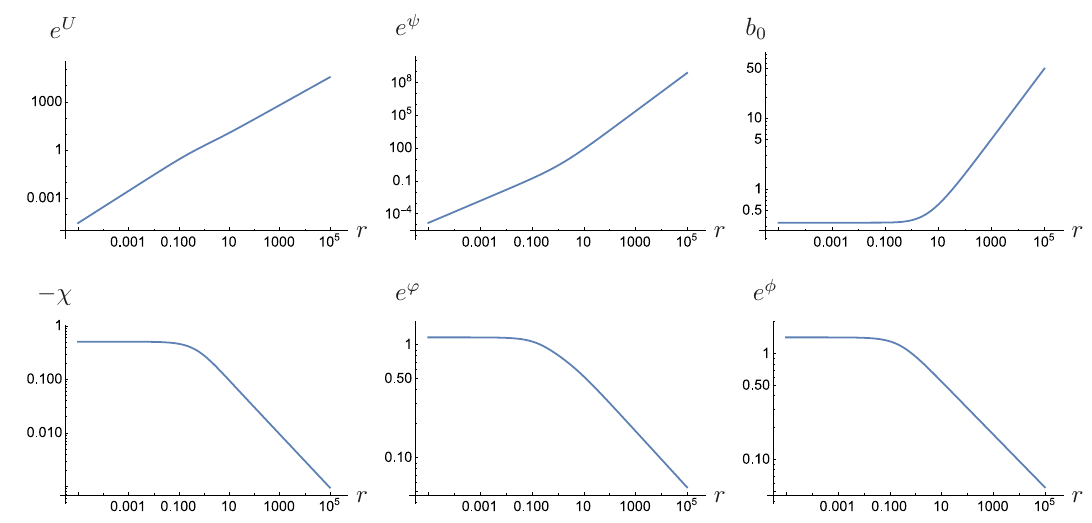
Figure 2 . Plots of the metric functions, scalars and tensor field profiles as a function of the radial coordinate. The numerical integration was performed with ( c 1 , c 2 ) = (